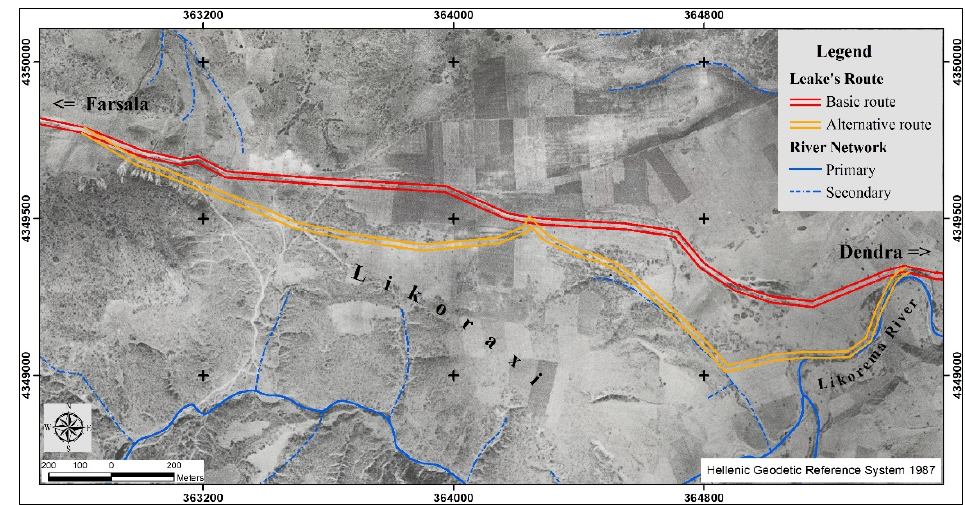
Figure 5. Section of the Farsala-Almyros route, as described by Leake.